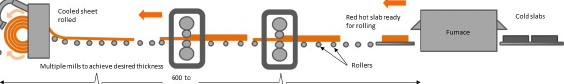
uneven surface profile and tilt in the rotation axis as shown in Figure 3. The unevenness, although a few millimeters, can af- fect the quality of the steel by creating differential roller surface speed which causes stripes on the steel surface. As shown in Figure 3(a), the axis of a roller may not be perfectly horizontal. Such a roller, due to varying friction over its length, could result in different roller radii. Figure 3(b) shows a roller with chan- ging radii along its